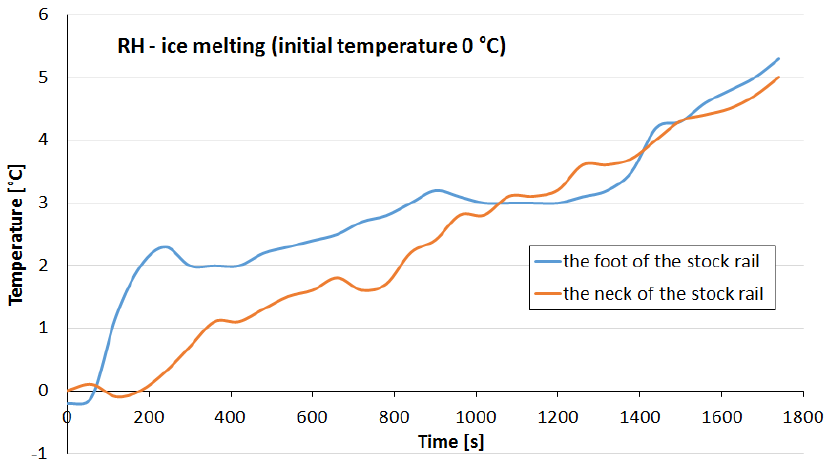
Figure 13. Foot and rail neck temperature vs. heating time in empty run of RH device for initial temperature 0 °C.